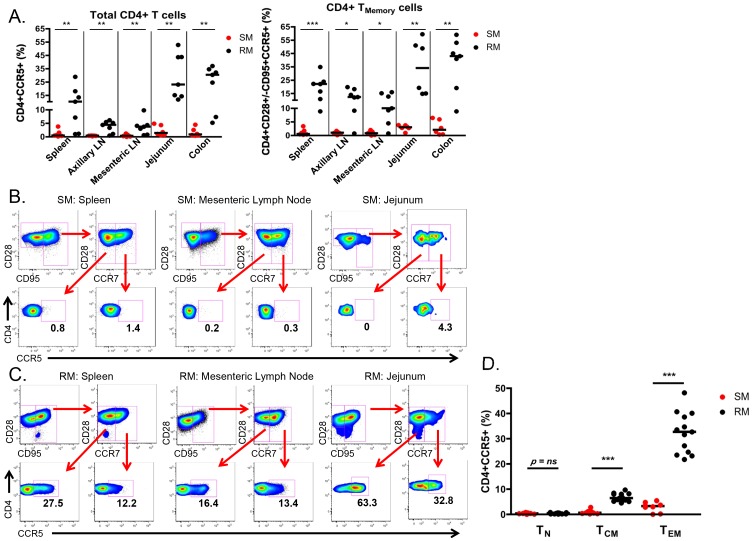
Few CD4+CCR5+ SIV target cells present in infant SMs.(A) The proportion of CD4+CCR5+ SIV target cells was measured by flow cytometry in total and memory CD4+ T cells isolated from lymphoid and gastrointestinal tissues of infant SMs (red) and RMs (black) at necropsy. Representative flow plots showing CCR5 expression on effector memory (CD28+CD95+CCR7−) and central memory (CD28+CD95+CCR7+) CD4+ T cells from the spleen, mesenteric LN, and jejunum from infant SMs (B) and RMs (C). (D) The percentage of CD4+CCR5+ T cells among the naïve (CD28+CD95−CCR7+), central memory (CD28+/−CD95+CCR7+), and effector memory (CD28+/−CD95+CCR7−) subsets in the peripheral blood of infant SMs (red) and RMs (black). Mann-Whitney test was used to determine significance. * p<0.05; ** p<0.01; *** p<0.001.